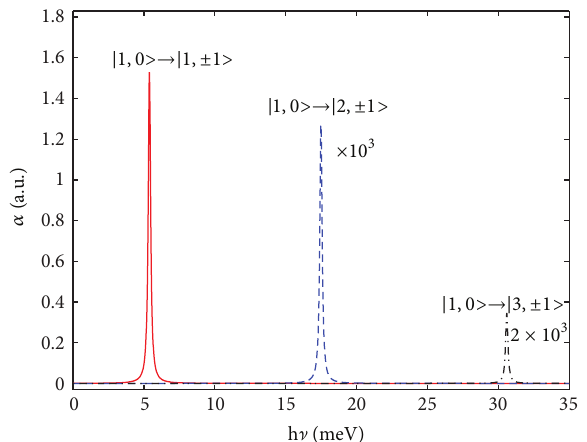
Figure 3: The optical absorption coefficients for transition from the ground state to the excited states as a function of incident photon energy for ℏ𝜔 = 6 meV and 𝐵 = 0 .